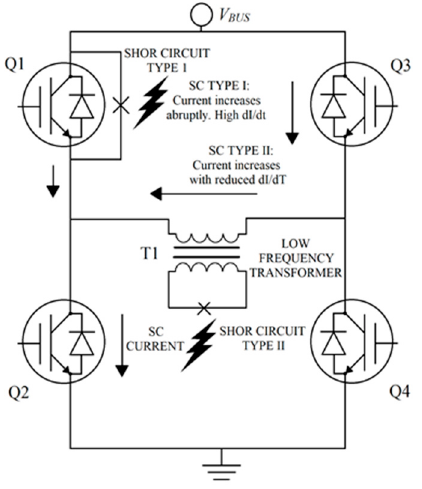
Figure 1. Short-circuit classification according to the current path through the full-bridge module. The figure identifies two types of short-circuits that feature sole electrical properties accordingly.